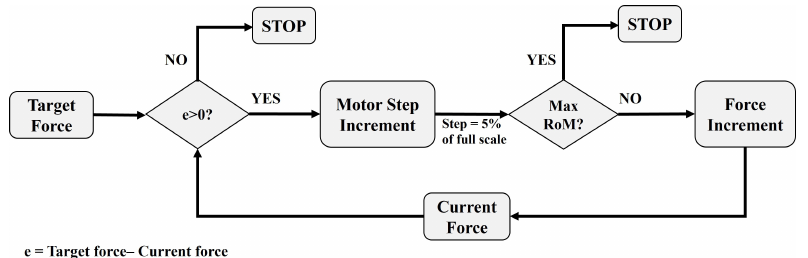
Figure 3. Block scheme of the strategy implemented for the active-assisted training. Every 3 s, the current force is compared with the target force. If the current force is lower than the target one, the position of the motor is updated by providing 5% of the full-scale position increment to generate additional grasping force. Moreover, the RoMs of the fingers are also evaluated every 3 s: if the RoM of one of the fingers exceeds the maximum RoM recorded in the calibration phase, the exercise ends.